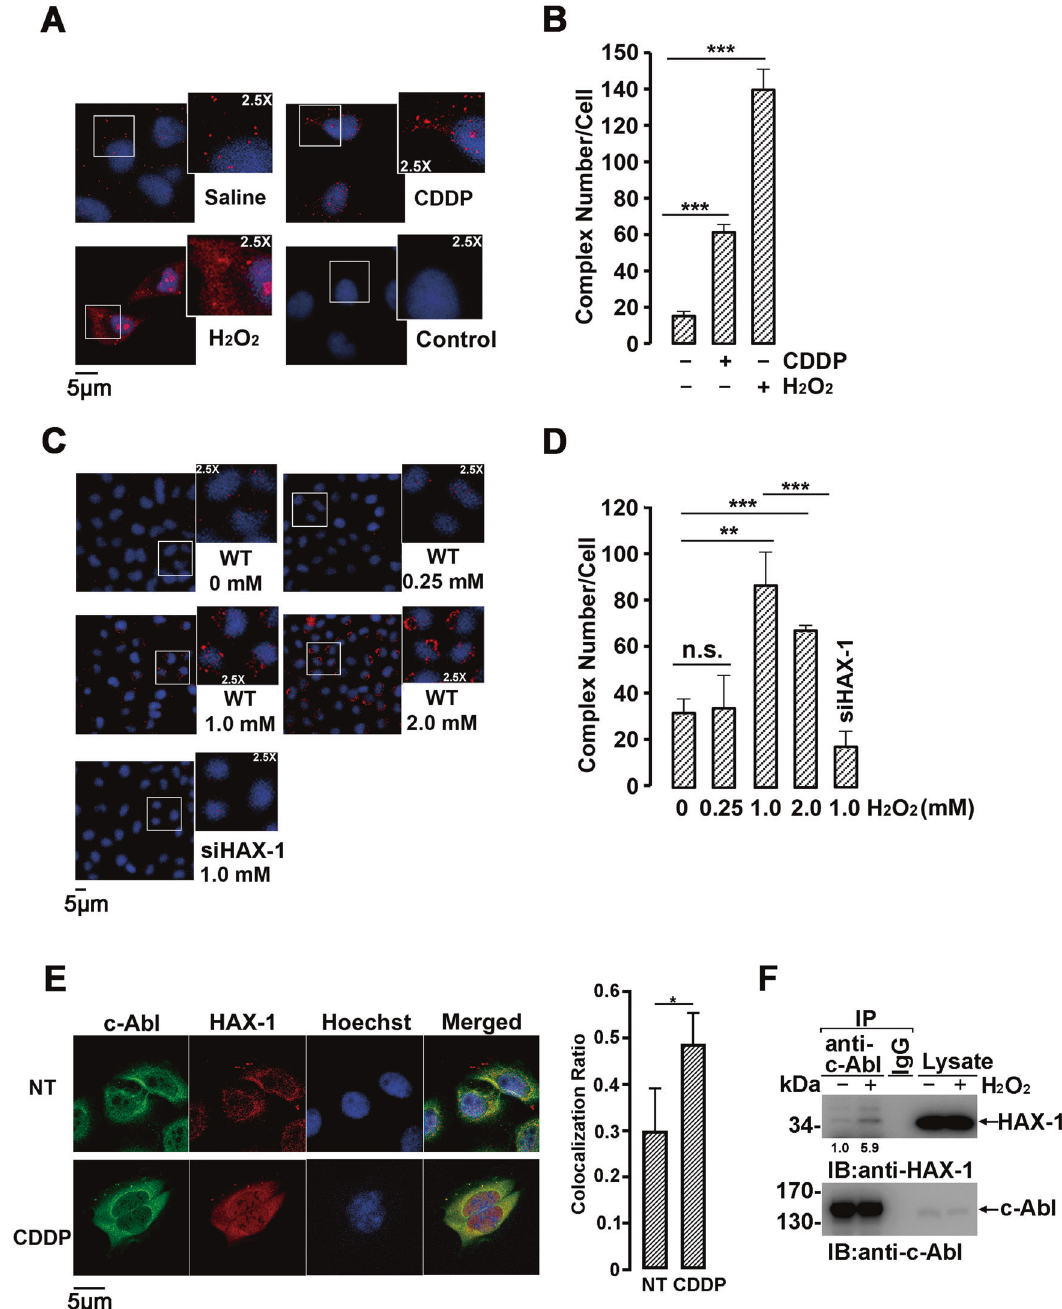
Fig. 2 Interaction of c-Abl with HAX-1 in different physiological contexts. A An in situ proximity ligation assay (in situ PLA) was used for the detection of HAX-1 and c-Abl binding complexes. MCF-7 cells treated with or without CDDP (25 mM, 8 h) or H 2 O 2 (1 mM, 3 h) were incubated with target primary antibodies from two different species or with anti-c-Abl antibody as a control. The red spots reveal c-Abl/HAX-1 interaction. Nuclei are stained with Hoechst 33342. Slides were evaluated using an LSM 510 META confocal microscope (Carl Zeiss). Cell images obtained were exported using the Zeiss LSM Image Browser (Carl Zeiss) in TIF format for further analysis. B Quanti fi cation of HAX-1-c- Abl interaction complexes. The number of complexes per cell was counted in at least three fi elds. Quanti fi cations were given as the mean±S.D. Representative results are shown from experiments repeated three times. *** p < 0.001, Student ’ s t test. C MCF-7 or HAX-1 siRNA cells treated with the indicated dosage of H 2 O 2 were subjected to in situ PLA analysis. D Quanti fi cation of HAX-1-c-Abl interaction complexes. The number of complexes per cell was counted in at least three fi elds. Quanti fi cations were given as the mean ± S.D. Representative results are shown from experiments repeated three times. n.s., not signi fi cant; ** p < 0.01, *** p < 0.001, Student ’ s t test. E MCF-7 cells treated with or without CDDP (25 mM, 8 h) were incubated with target primary anti-c-Abl and anti-HAX-1 antibodies and then incubated with FITC- or TRITC-linked secondary antibodies. Nuclei are stained with Hoechst 33342 (left). The relative colocalization ratio of HAX-1 with c-Abl was analyzed by ImageJ software (right). At least 15 cells were analyzed, and the data were shown as mean±S.D. * p < 0.05, Student ’ s t test. F Lysates prepared from MCF-7 cells treated with or without H 2 O 2 (1 mM, 3 h) were analyzed by immunoprecipitation and immunoblotting.